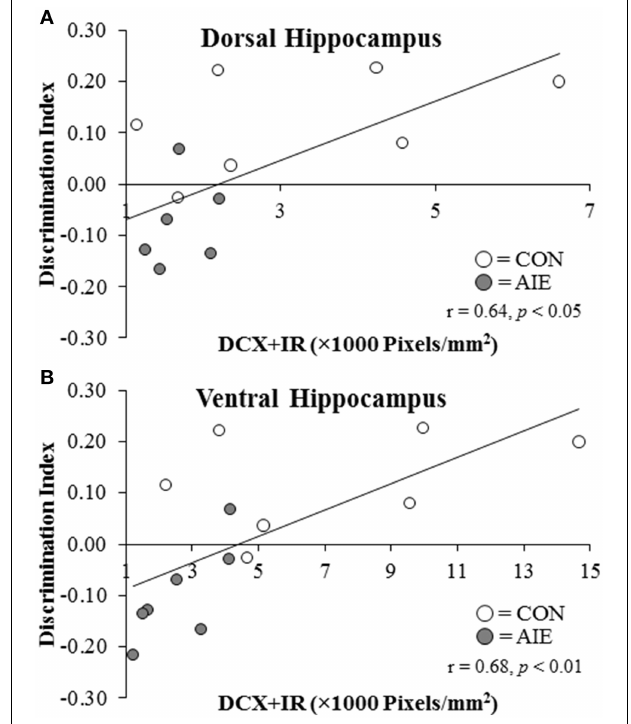
FIGURE 7 | Doublecortin immunoreactivity (DCX + IR) in the dorsal and ventral hippocampal dentate gyrus of P220 adult rats is correlated with object recognition memory performance. Performance on the open-field object recognition memory test is positively correlated with DCX + IR in the (A) dorsal hippocampus ( r = 0 . 64, N = 14, p < 0 . 01) and (B) ventral hippocampus ( r = 0 . 68, N = 14, p < 0 .